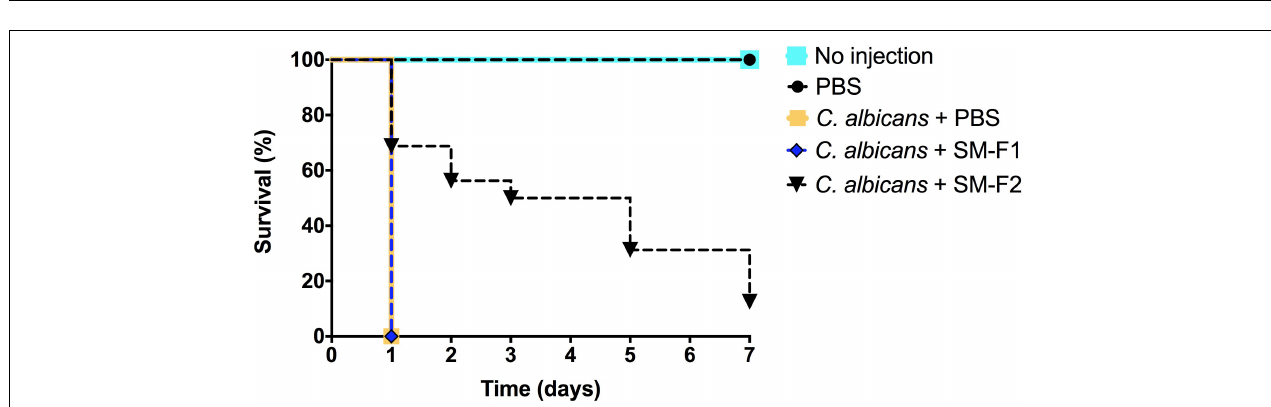
FIGURE 4 | Relative expression of C. albicans genes. Relative quantification of CPH1 , EFG1 , HWP1 , and UME6 genes (A) and YWP1 gene (B) for the non-treated control group (PBS) and treated group with SM-F2 (10 mg/mL). Each gene was normalized using the reference gene PMA1. Values were expressed as the mean and SD. The Student’s t -test was used to compare gene expression between the control and treated group (** p < 0.01 and *** p < 0.0001).